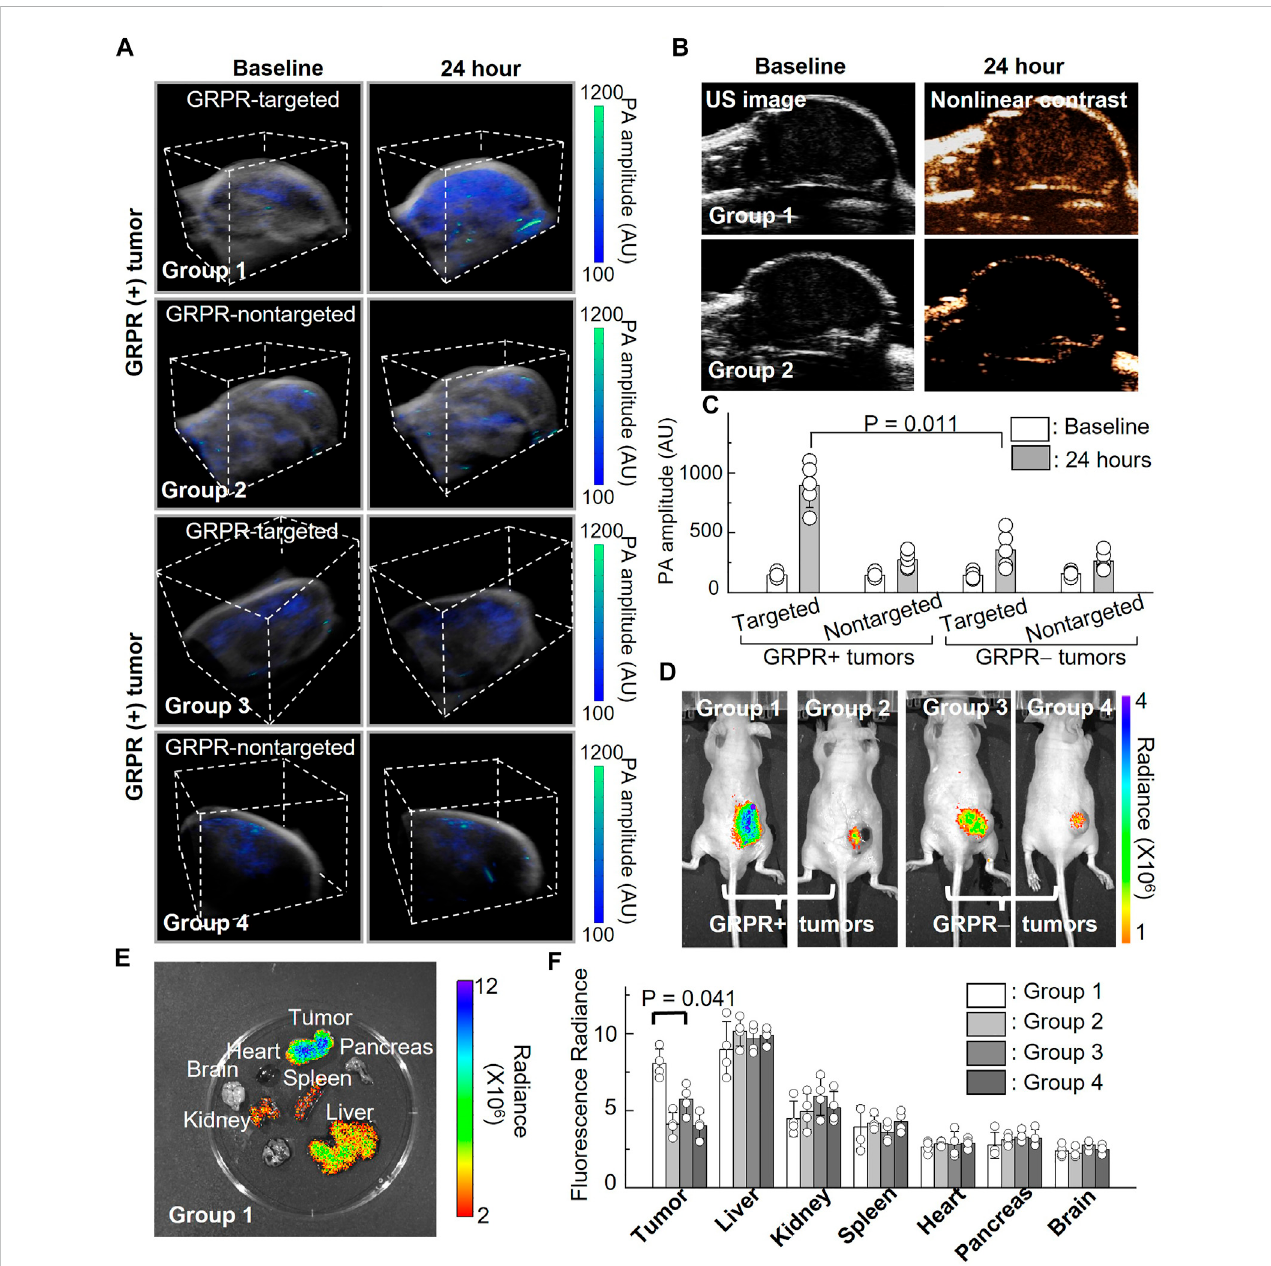
FIGURE 5 In vivo imaging of ICG nanobubbles in a murine model of prostate cancer. (A) Dual modal 3D photoacoustic/ultrasound images of GRPR+ and GRPR- tumor-bearingmiceinjectedwithnon-targetedortargetedICGnanobubbles(Groups1 – 4).Thescanningvolumeis23 mm(x)×19 mm(y)×16 mm(z). (B) 2D ultrasoundimageandnon-linearcontrastultrasoundimageofGRPR+tumor-bearingmicewithnon-targetedortargetedICGnanobubbles(Groups1 – 2). (C) Photoacoustic signal of GRPR+ and GRPR- tumor-bearing mice injected with non-targeted or targeted ICG nanobubbles (Groups 1 – 4). Bar chart showing sample means (n = 5) with standard-deviation error bars. (D) Fluorescence images of tumor-bearing mice in Groups 1 to 4. (E) A representative fl uorescenceimageofharvestedkidney,brain,tumor,heart,spleen,pancreasandliverfromthetumor-bearingmouseinGroup1. (F) Fluorescenceintensities from the main organs and tumors from the mice in Groups 1 – 4. Bar chart showing sample means (n = 4) with standard-deviation error